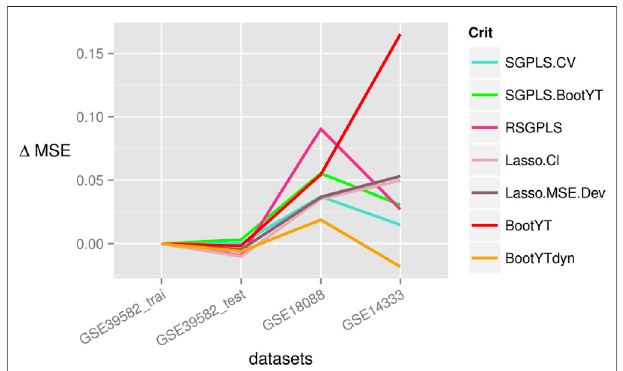
FIGURE 6 | Differences between the MSE computed on the training subset of the original dataset and the PMSE obtained on test